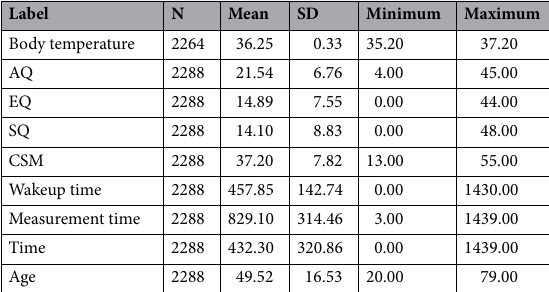
Table 5. Descriptive statistics of data in Survey 2.